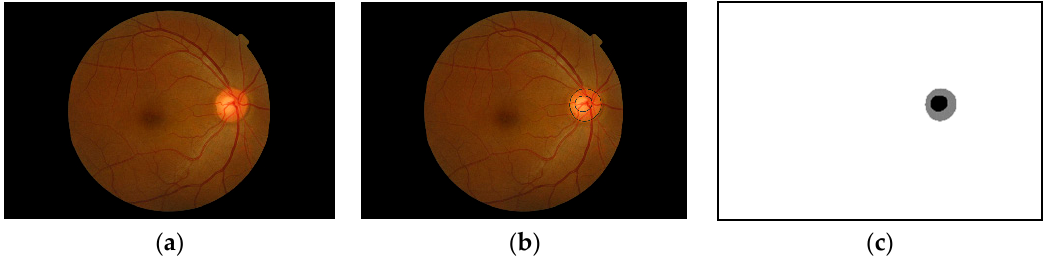
Figure 1. ( a ) A fundus image with ( b ) ophthalmologist annotation and ( c ) the generated ground truth mask for the optic disc and cup used in training and testing.